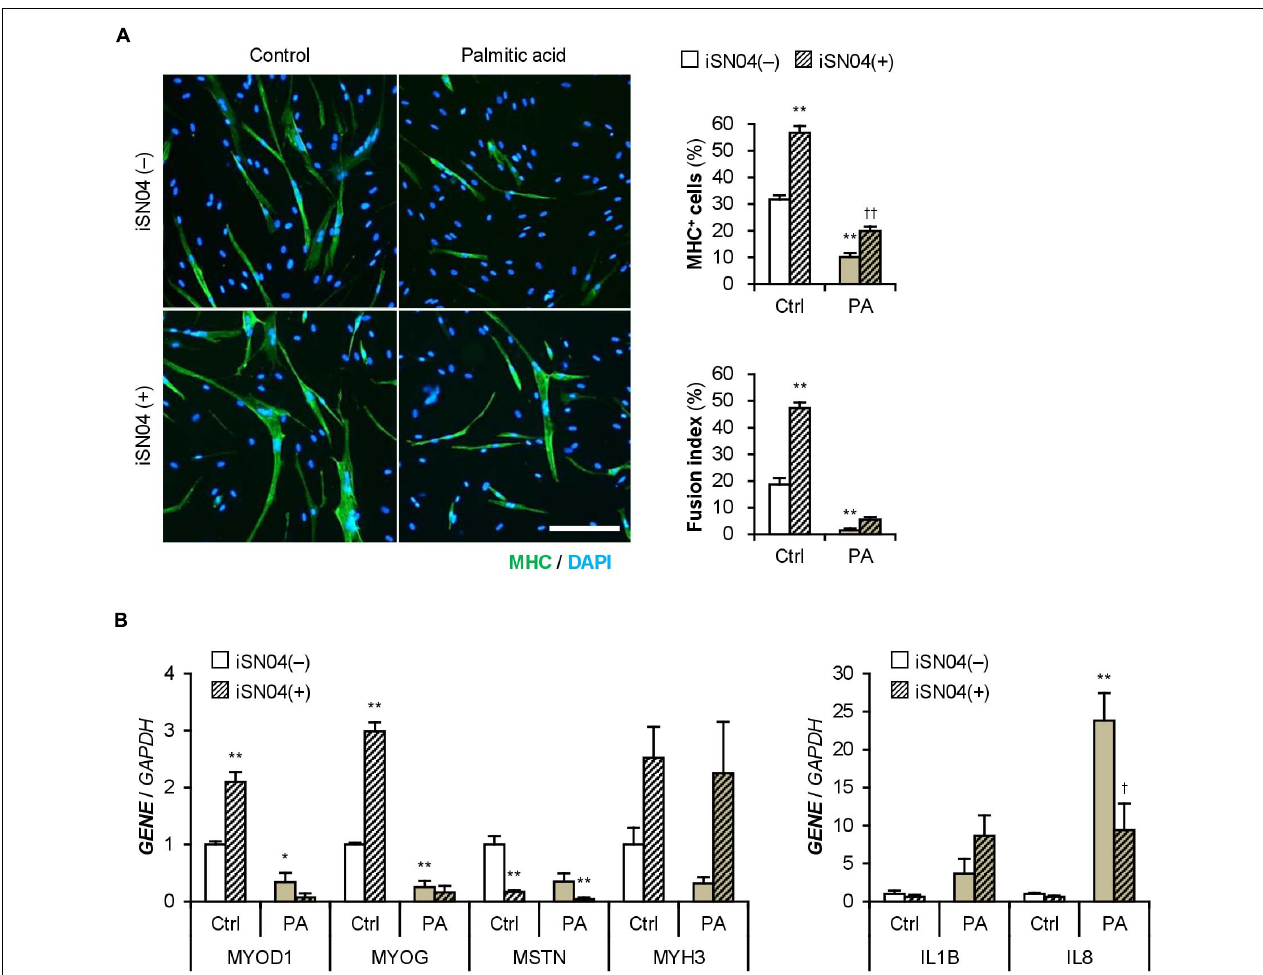
FIGURE 8 | iSN04 recovers the myoblast differentiation impaired by excessive palmitic acid. (A) Representative immunofluorescent images of the H35M myoblasts differentiated in DIM-NG with palmitic acid and iSN04 for 2 days. Scale bar, 200 µ m. Ratio of MHC + cells and multinuclear myotubes were quantified. ** p < 0.01 vs. control-iSN04(–); †† p < 0.01 vs. PA-iSN04(–) (Tukey–Kramer test); n = 6. (B) qPCR results of gene expression in the H35M myoblasts differentiated as in panel (A) . Mean value of control-iSN04(–) group was set to 1.0 for each gene. * p < 0.05, ** p < 0.01 vs. control-iSN04(–); † p < 0.05 vs. palmitic acid-iSN04(–) (Tukey–Kramer test); n =